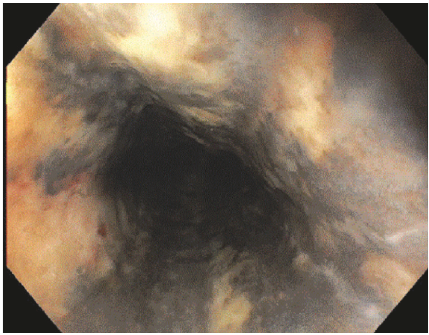
Figure 1: Initial EGD upon presentation showing severe necrosis in the middle to lower third of the esophagus.